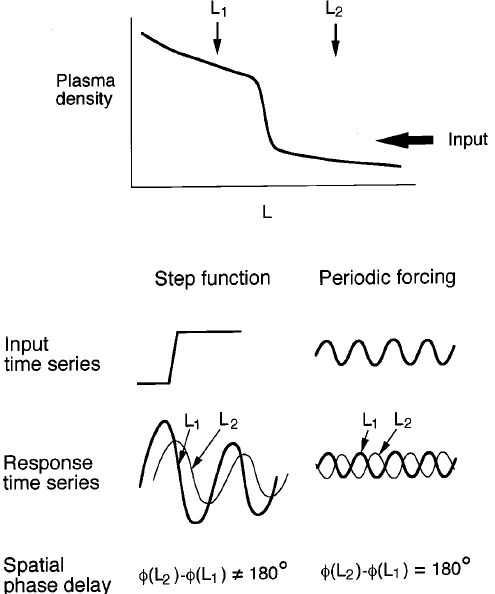
Fig. 11. Response of the magnetosphere to two types of input time series, a step function ( left ) and a sinusoid ( right ), a graphical summary of the numerical study by Itonaga et al . (1997). The wave form and phase relation between two radial distances L illustrated at the bottom